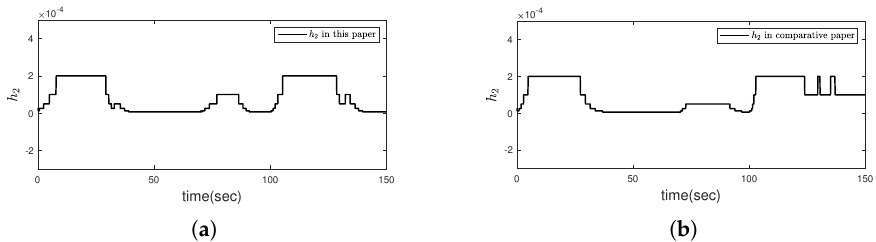
Figure 8. ( a ) The estimation curve of unknown parameter h 2 in this paper. ( b ) The contrastive curve of unknown parameter h 2 in method that ignores the effect of thruster saturation in [15].